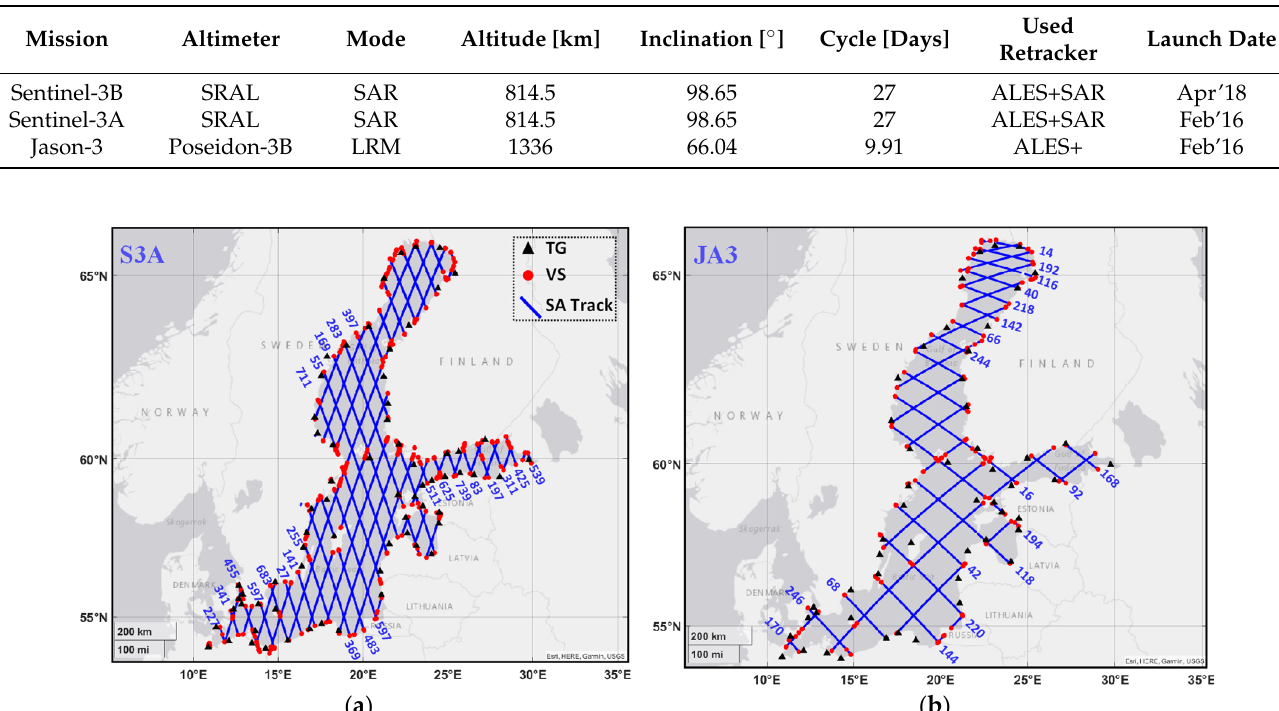
Table 2. The used SA missions and their main specifications.